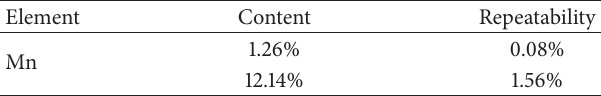
Table 5: Repeatability of the measurement results.